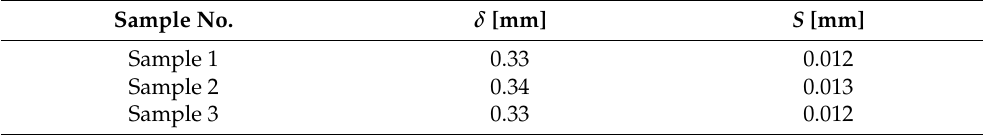
Table 3. Results of verification tests for a case with an adaptive control